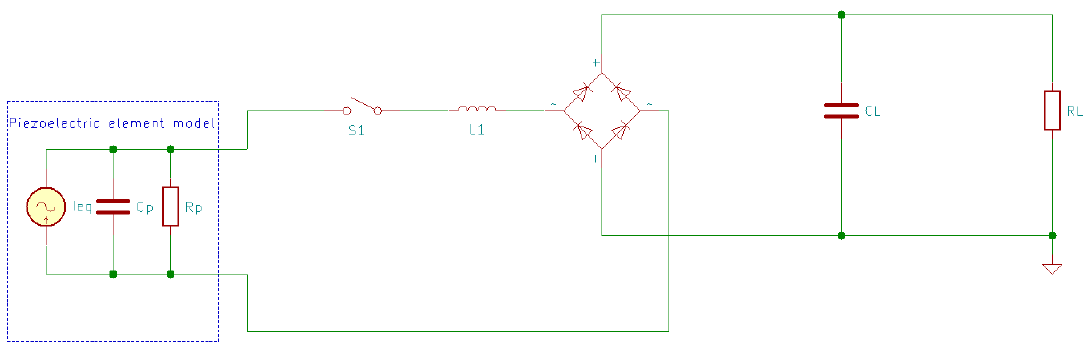
Figure 20. Series-SSHI energy harvesting circuit.